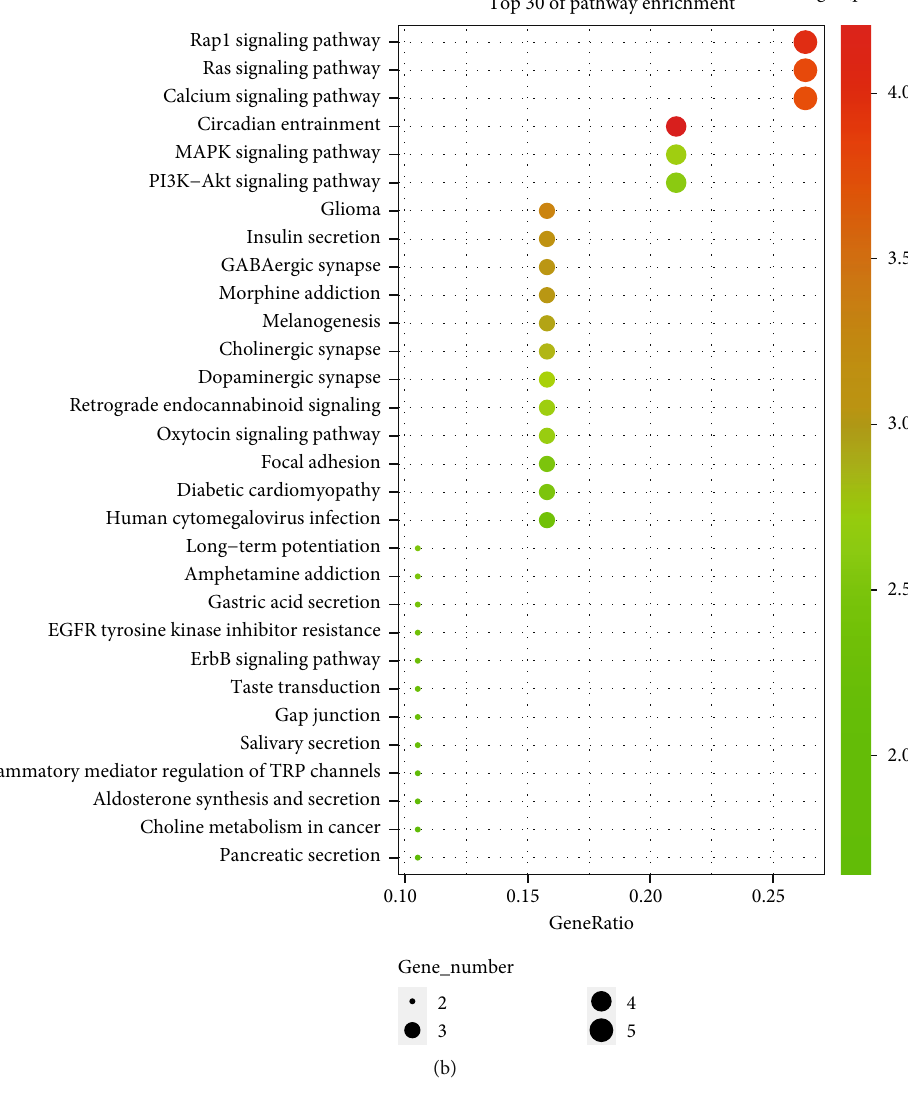
Figure 5: miRNA DEGs enrichment analysis. (a) GO enrichment analysis and (b) KEGG enrichment